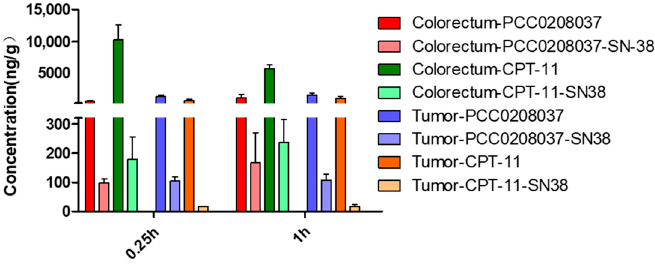
Figure 10. The tissue distribution of PCC0208037 in mice. The colorectum and tumor concentrations of PCC0208037 and its major metabolite, SN-38, in LS180 xenograft tumor mice. The data were expressed as the mean ± SD ( n = 3).